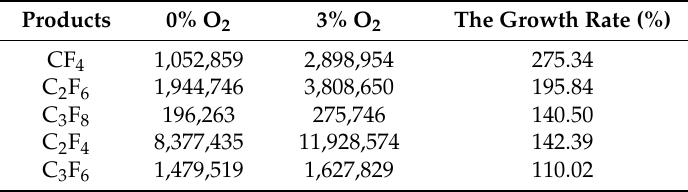
Table 2. Peak strength of c-C 4 F 8 /N 2 mixed gas decomposition products under different O 2 contents.